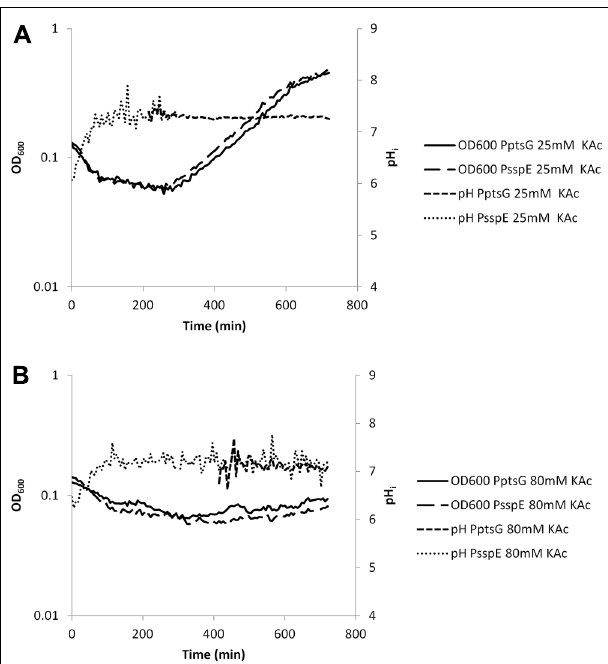
FIGURE 7 | Internal pH during spore germination and outgrowth. IpHluorin accumulated in the spores (from expression controlled by P sspE ) allows pH measurements from t = 0 to approximately 300 min. Expression of IpHluorin from P ptsG allows calculation of the pHi from approximately 200 min. Data are from a representative example. (A) Germination and outgrowth of B. subtilis spores at an external pH = 6.4 with 25 mM KAc. (B) Germination and outgrowth of B. subtilis spores at an external pH = 6.4 with 80 mM KAc.